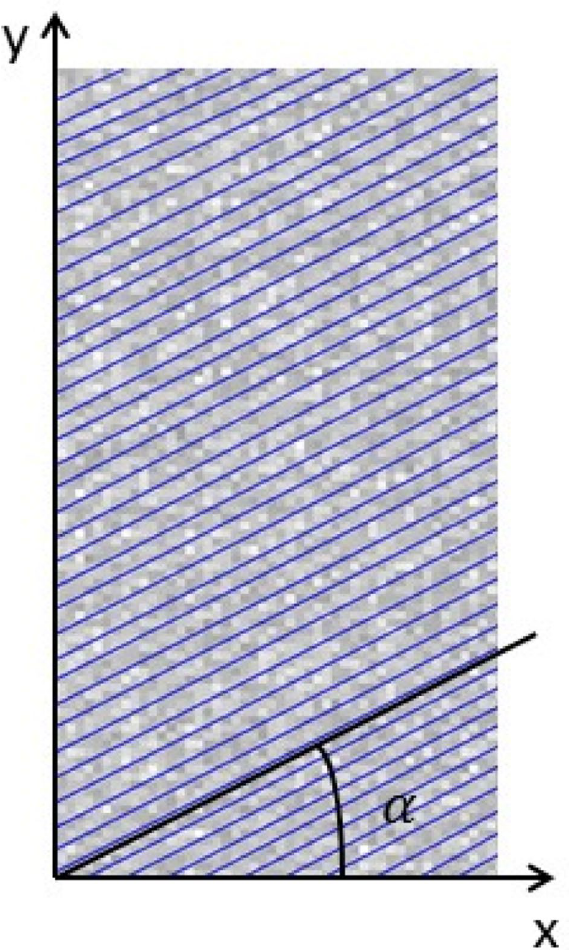
Figure 20. Schematic diagram of phyllite model.